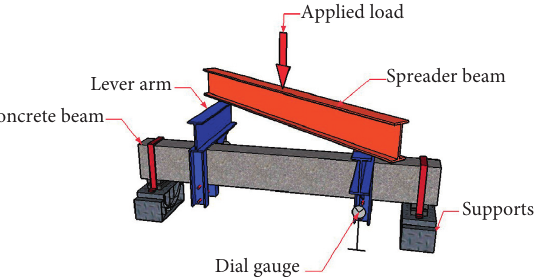
Figure 6: Schematic diagram of the test set-up for applying combined torsion and bending.